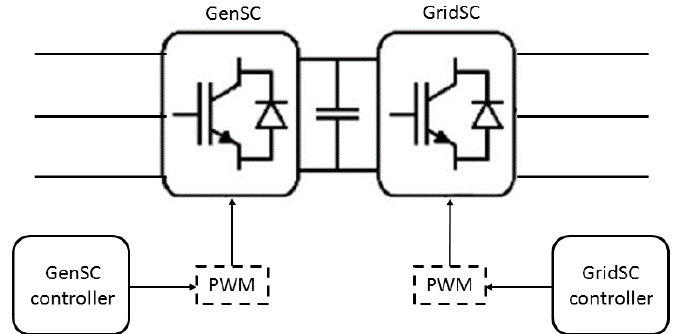
Figure 29. Power converter controllers and pulse width modulation (PWM)